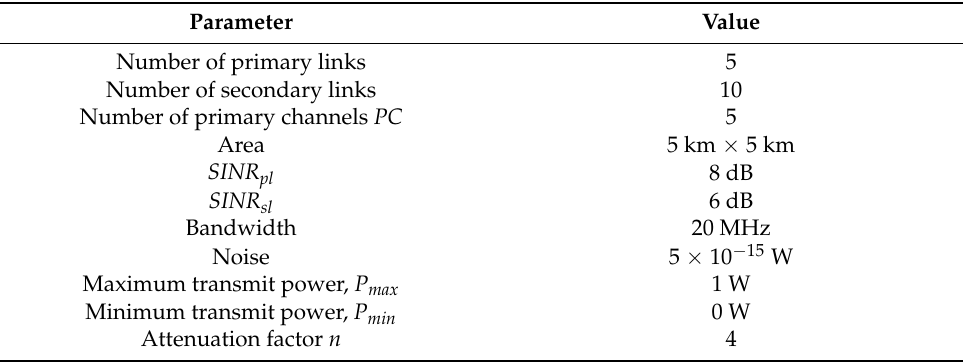
Table 5. Cognitive radio (CR)